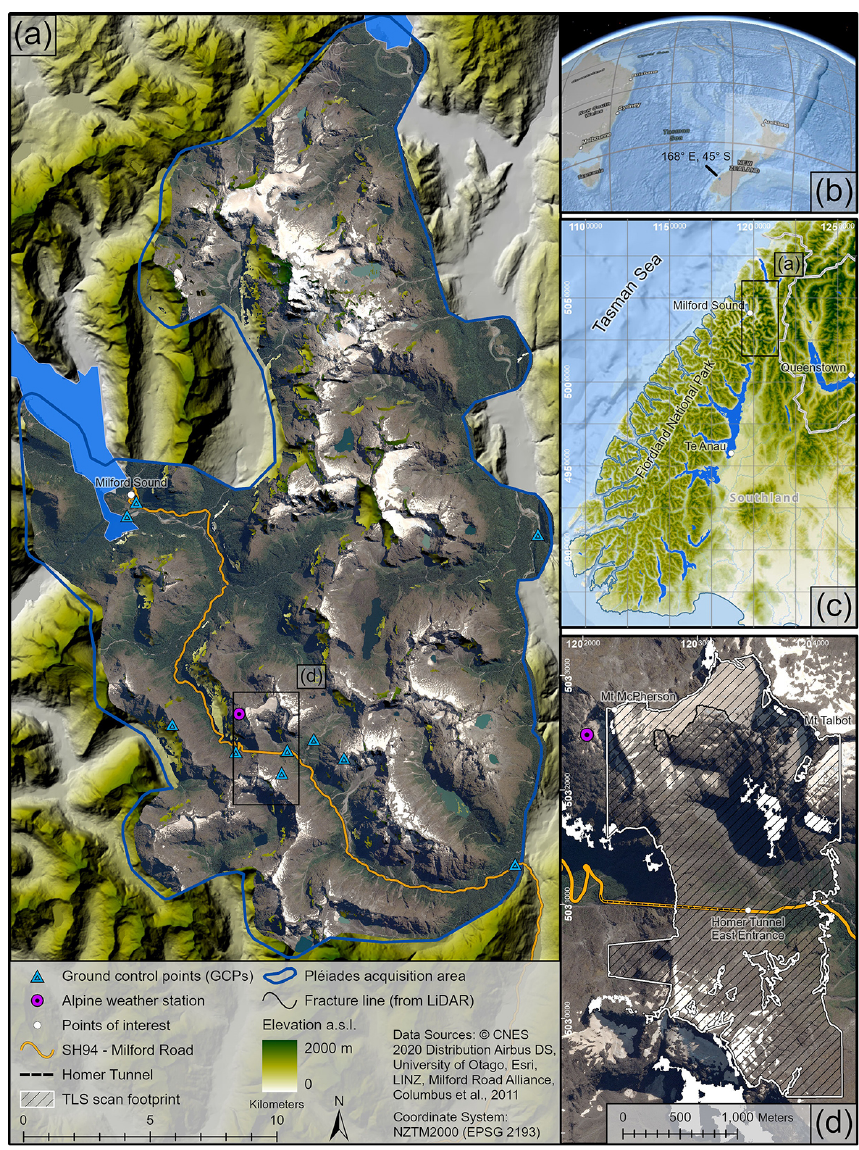
Figure 1. Overview of study site with footprint of satellite imagery and location of ground control points (GCPs) in panel (a) , reference maps in panels (b) and (c) , and inset map showing the footprint of TLS data extent and McPherson 2020 avalanche fracture line in panel (d) . SH94 Milford Road and the alpine weather station are also shown in panels (a) and (d)